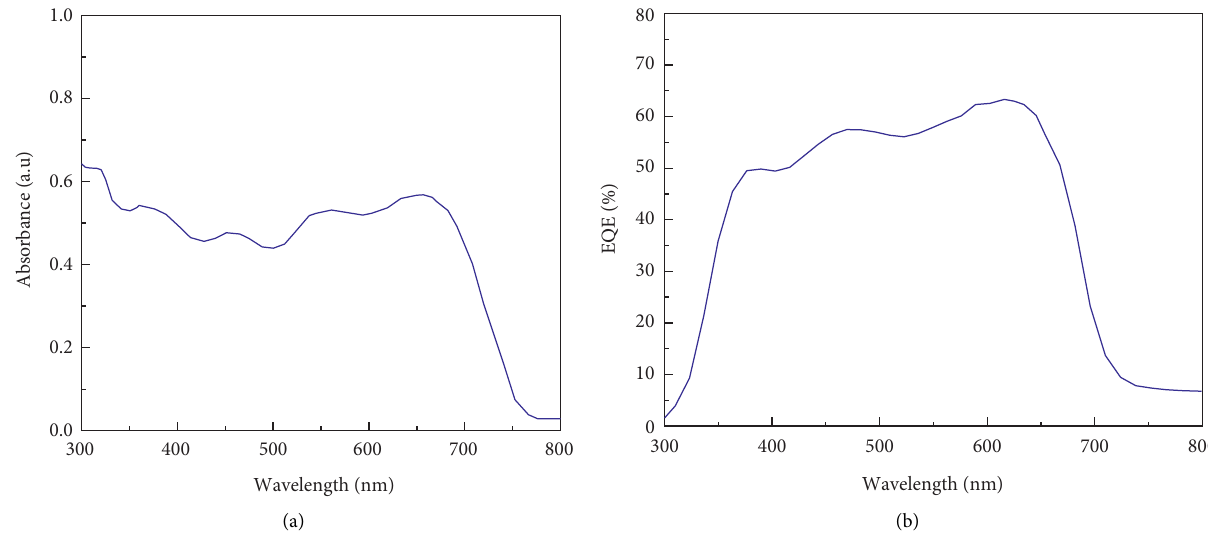
Figure 7: (a) Absorbance of PTB7 :PC70BM and (b) EQE spectra of ITO/V2O5/PTB7: